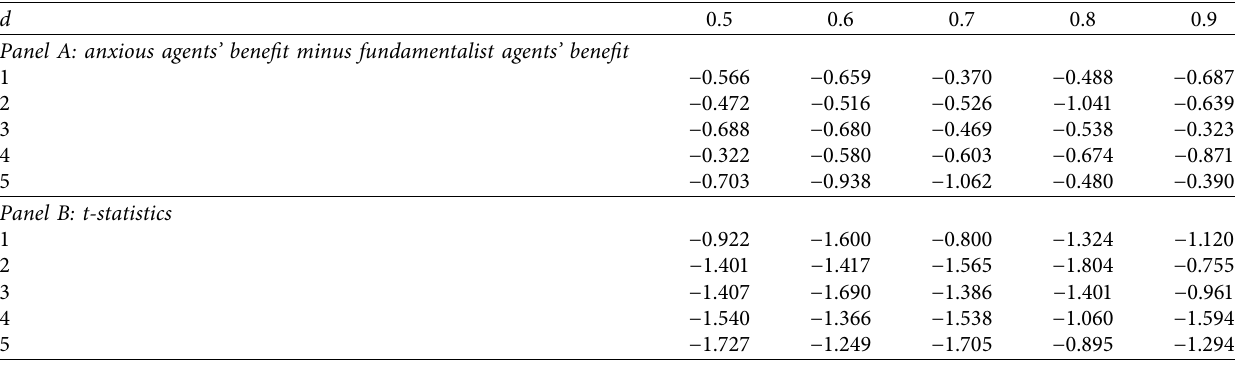
Table 6: Agents’ strategic benefit in considering the LSTM. Note: In this table, we report the difference in strategic benefit between anxious agents and fundamentalist agents and related t -statistics. More specifically, the anxious agent maintains the original route to obtain the expectation for price, while the fundamentalist agent applies the long short-term memory (LSTM) neural network to acquire the expectation for price. The market proportion of the anxious agent lies between 0.5 and 0.9. d denotes the magnitude of behavioral hesitation and decision rigidity. It extends from 1 to